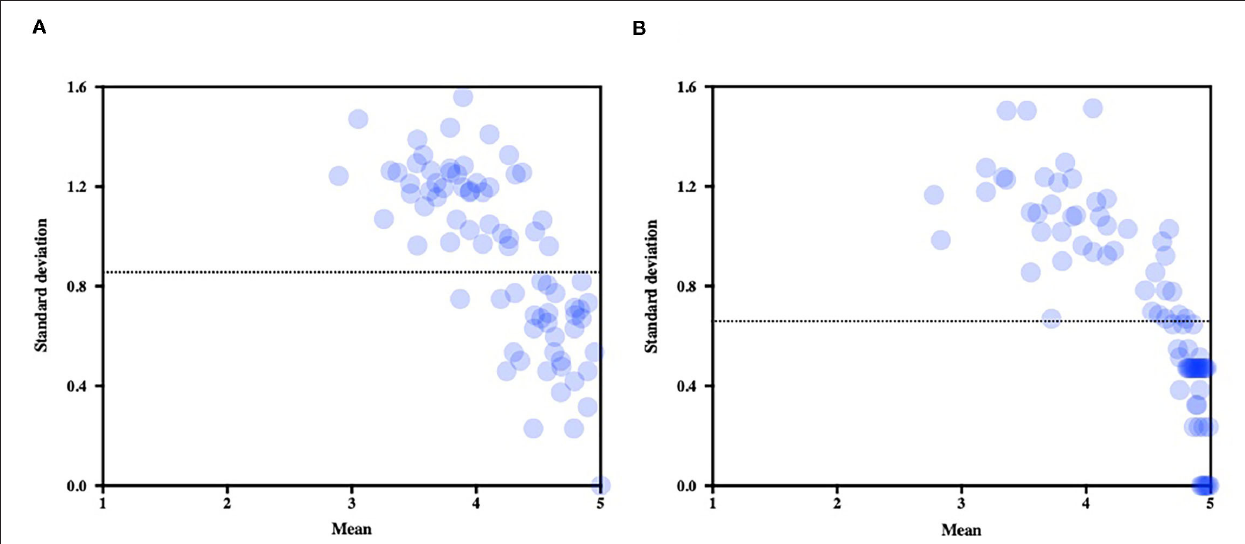
FIGURE 4 | Mean scores (standard deviations expressed against the means) for each item of the questionnaire. Note the decrease of variability after the second round (B) as compared to the first round (A) . The dotted line represents the average standard deviation in each round.